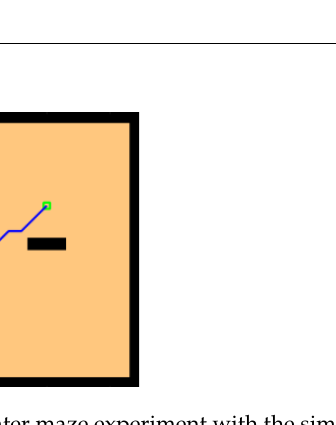
Figure 12. Water maze experiment with the simple obstacles.